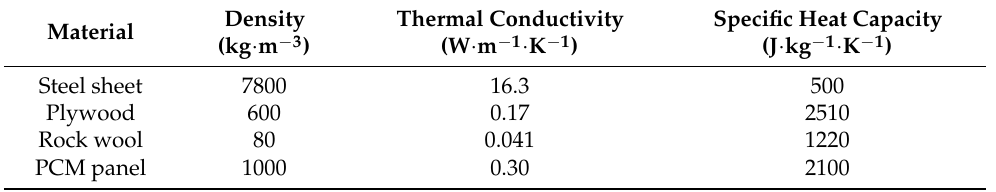
Table 6. Thermophysical properties of the building materials.